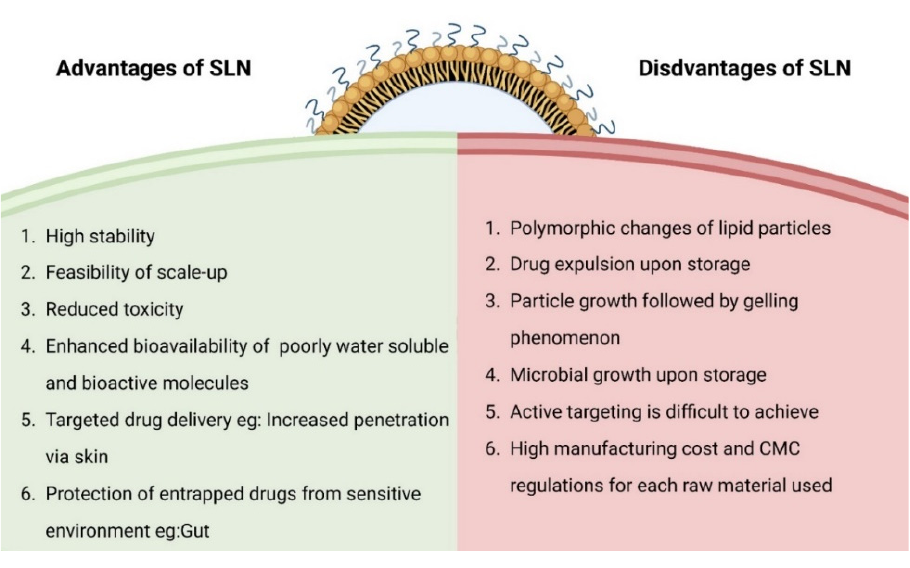
Figure 1. Advantages and disadvantages of SLN, data summarized from references [7,8].